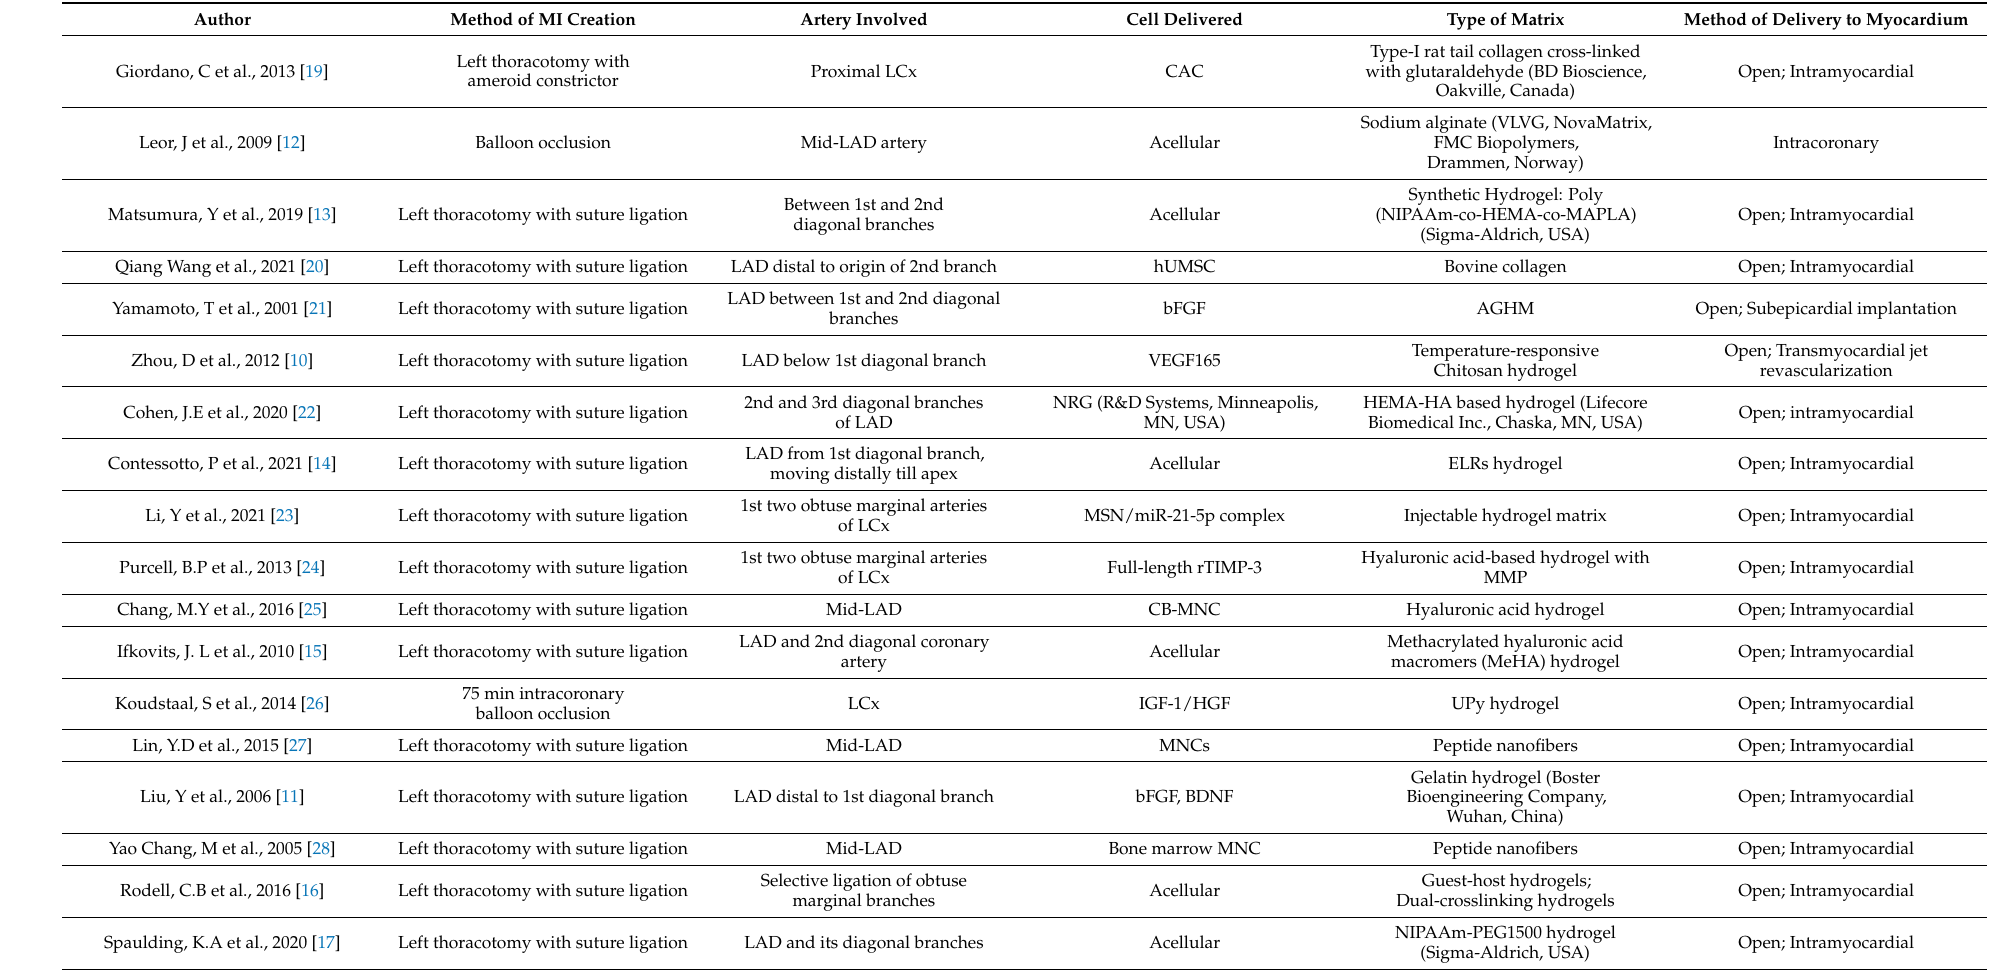
Table 3. Hydrogel characterization and mode of